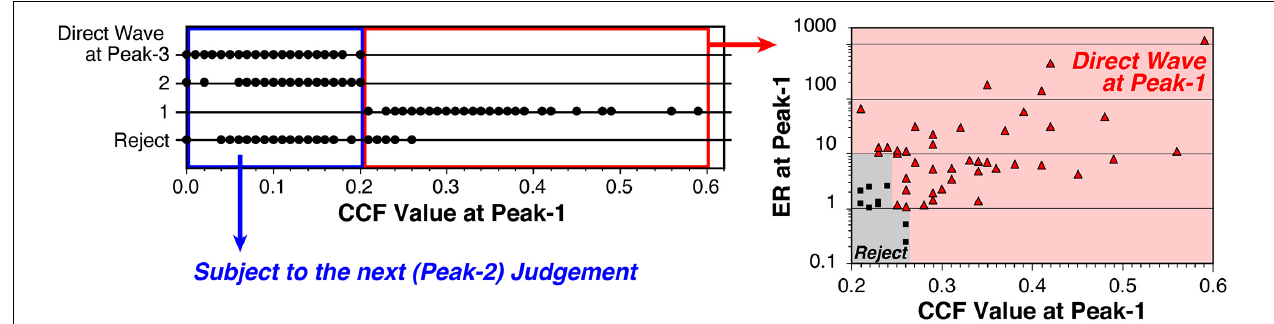
FIGURE 10 | Example of thresholds to recognize the direct wave onset on the basis of the CCF and ER values. Graphs displayed here are for the judgment at Peak-1 among the waveform data recorded on the buoy from March 28 to July 12, 2018. For this case, the peaks with CCF values > 0.20 (red square frame in the left panel) are judged whether they correspond to the direct wave onset (red shadow in the right panel) or Reject (gray shadow in the right panel). The peaks with CCF values ≥ 0.27 unconditionally correspond to the direct wave onset. The peaks with CCF values > 0.20 and < 0.27 are judged to be the direct wave onset or Reject depending on both their CCF and ER values. The remaining data (blue square frame in the left panel) are subjected to the judgment at Peak-2. TABLE 1 | Result of the automatic recognition of the direct wave onset. Actual (manually checked) Direct wave onset at: Total Peak-1 Peak-2 Peak-3